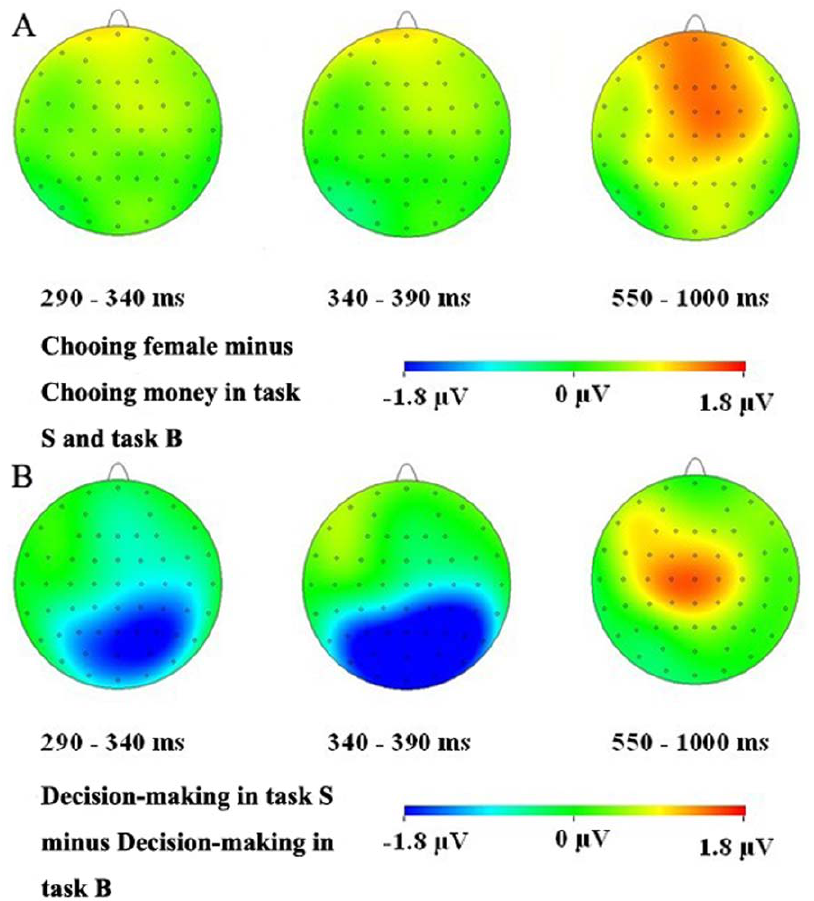
Figure 3. Topographic maps of voltage amplitude difference of two kinds of decisions and tasks. (A) choosing attractive females minus choosing money in task S and B in three time windows of 290–340 ms, 340–390 ms and 550–1000 ms, respectively. (B) decision-making in task S minus that in task B in three time windows of 290–340 ms, 340–390 ms and 550–1000 ms, respectively.